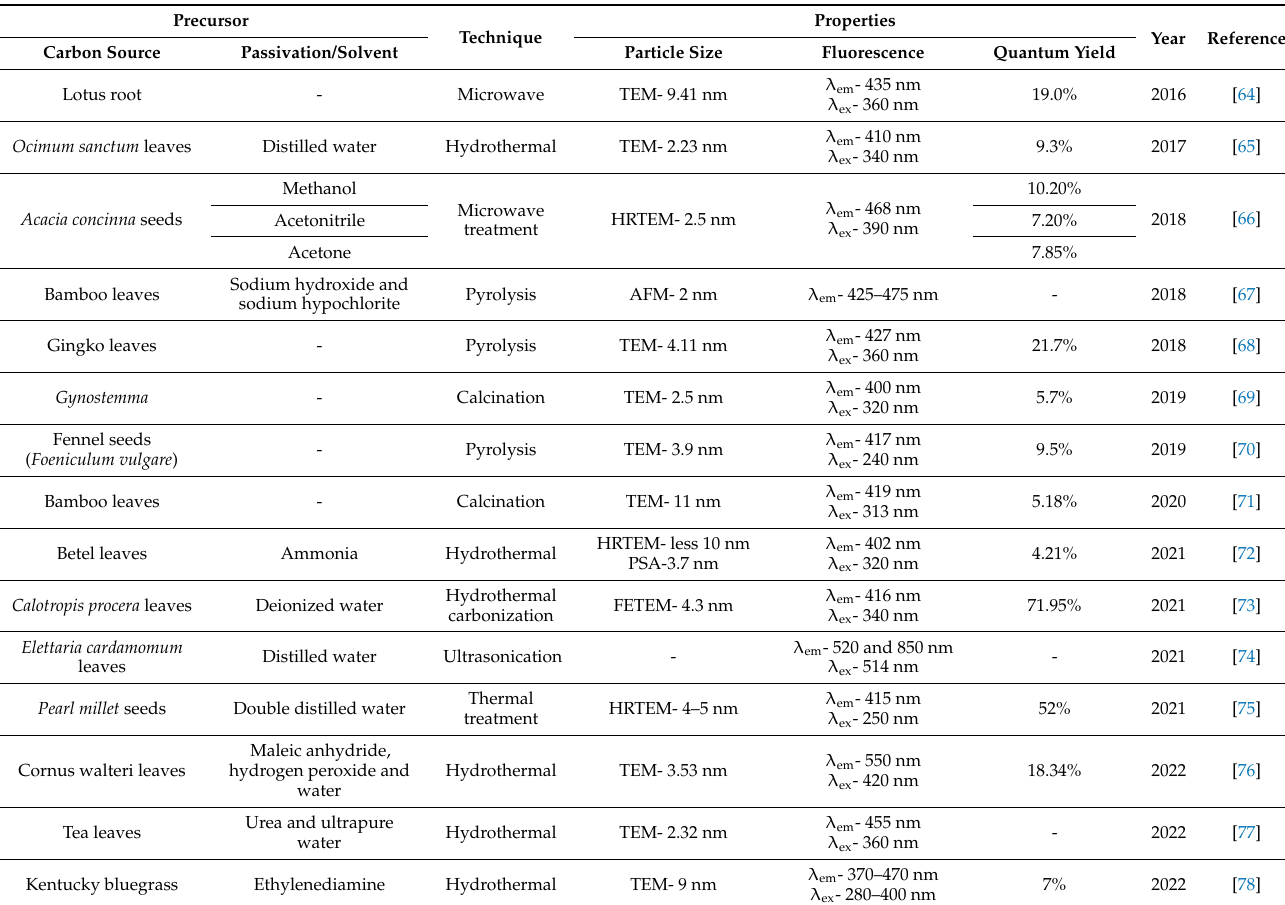
Table 4. Summary of the synthesis of CDs from leaves, seeds, and